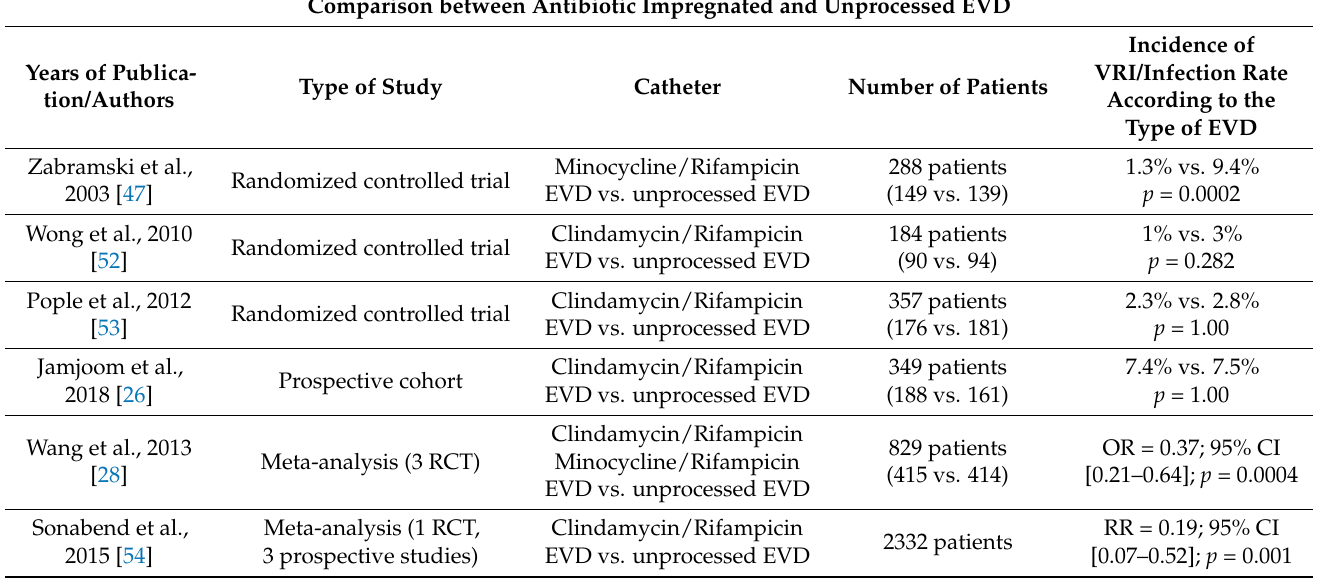
Table 2. Effectiveness of antibiotic-impregnated compared to unprocessed EVD in clinical practice. Comparison between Antibiotic Impregnated and Unprocessed